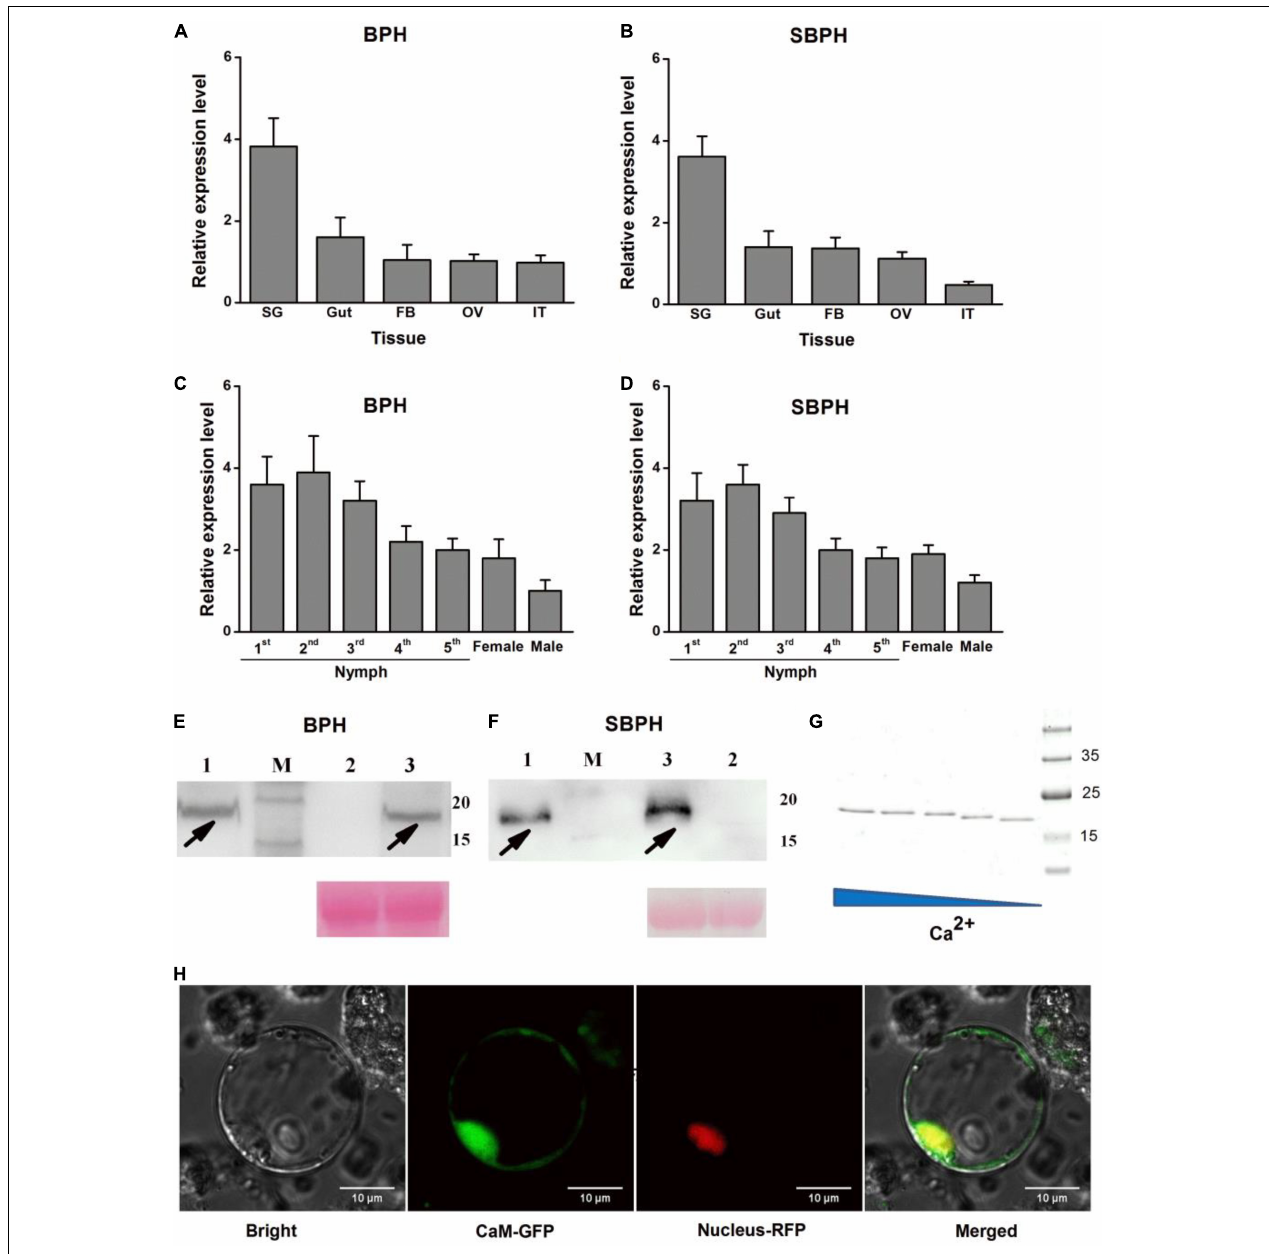
FIGURE 4 | Molecular characterization of CaM. (A–D) Mean transcript levels + SE ( n = 3) of LsCaM and NlCaM in BPH (A,C) and SBPH (B,D) whole bodies at various developmental stages (A,B) and in various tissues (C,D) . SG, salivary gland; OV, ovary; FB, fat body; IT, integument. (E,F) CaM secretion by BPH (E) or SBPH (F) into host rice. Western blot analysis of CaM. Lane 1 shows extracts of BPH (E) or SBPH (F) salivary glands. Lanes 2 and 3 represent extracts of uninfested control rice leaf sheaths (lane 2) or rice leaf sheaths infested with fifth-instar nymphs of BPH (E) or SBPH (F) . M, molecular weight marker (kDa). Equal loading of plant samples (lanes 2 and 3) was indicated by Ponceau stained-Rubisco protein (PS). Black arrowheads indicate CaM target bands. (G) SDS-PAGE showing Ca 2 + -dependent mobility of recombinant protein CaM. Purified CaM was incubated at 25 ◦ C for 30 min as follows: lane 1, 0.5 mM CaCl 2 ; lane 2, 0.15 mM CaCl 2 ; lane 3, 0.05 mM CaCl 2 ; lane 4, 0.015 mM CaCl 2 ; lane 5, 0.5 mM EDTA. (H) Transiently expressed CaM was localized to rice cell cytoplasms and nuclei. CaM-GFP fusion protein was expressed in rice protoplasts by polyethylene glycol-mediated transformation. Protein distribution was investigated by confocal laser-scanning microscopy at 16 h after transformation. Bars = 10 µ